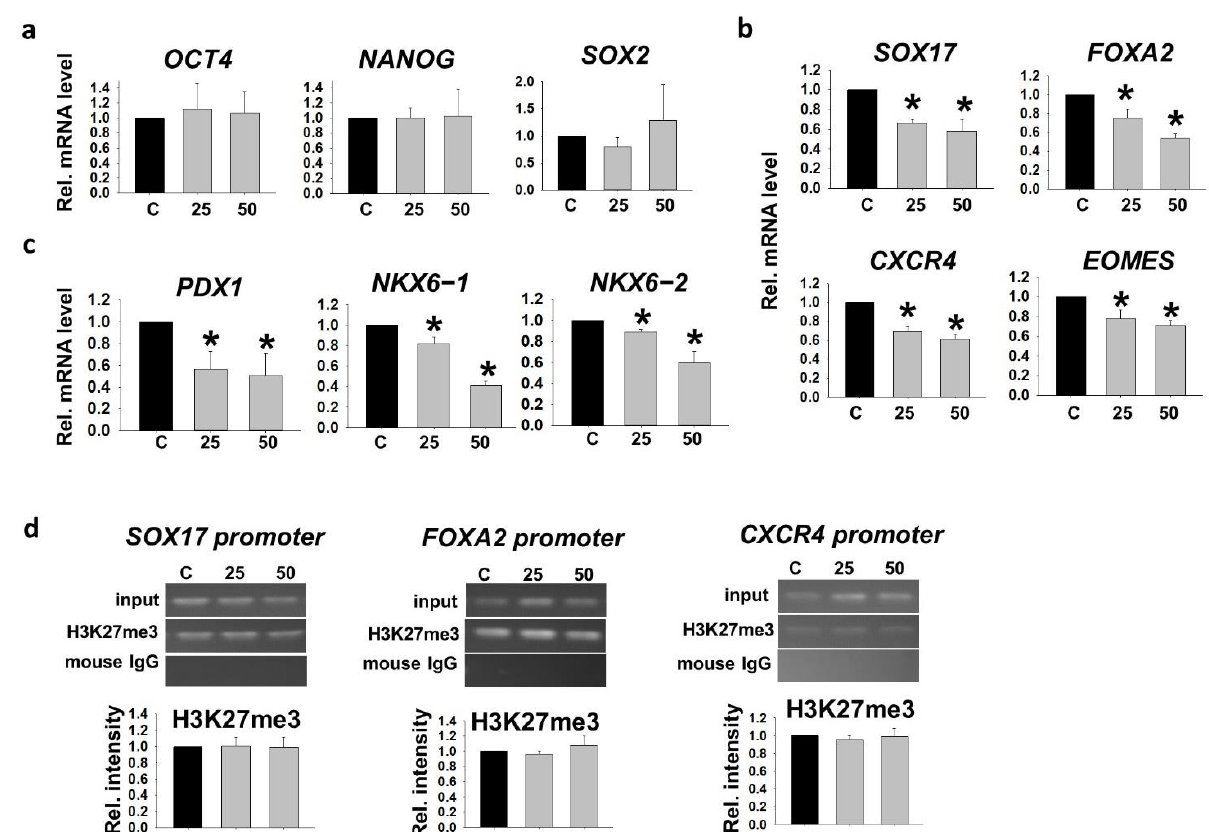
Figure 1. Human embryonic stem cell (hESC) cultured in hyperglycemic conditions showed disrupted pancreatic differentiation potential. ( a ) The relative mRNA levels of pluripotent markers ( OCT4 , NANOG and SOX2 ) in undifferentiated VAL3 under hyperglycemic conditions (C: 13.7 mM D-glucose) ( n = 4). ( b ) The relative mRNA levels of definitive endoderm (DE) markers ( SOX17 , FOXA2 , CXCR4 and EOMES ) in DE cells from different conditions of VAL3 ( n = 4, * p < 0.05 compared to control, one-way ANOVA followed by Student–Newman–Keuls). ( c ) The relative mRNA levels of pancreatic progenitor (PP) markers ( PDX1 , NKX6 − 1 and NKX6 − 2 ) in PP cells from different conditions of VAL3 ( n = 4, * p < 0.05 compared to control, one-way ANOVA followed by Student–Newman–Keuls). ( d ) The H3K27me3 binding levels on the promoters of DE markers in undifferentiated VAL3 under hyperglycemic conditions ( n = 3).